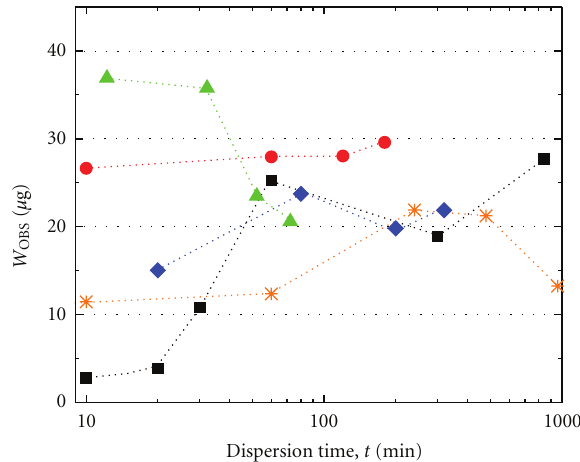
Figure 7: Total detected mass between 20 nm and 2 μ m, W OBS , as a function of sonication time and horn amplitude: 10% ( (cid:2) ), 20% ( (cid:3) ), 40% ( • ), 70% ( (cid:4) ), and bath sonicator ( ∗ ).